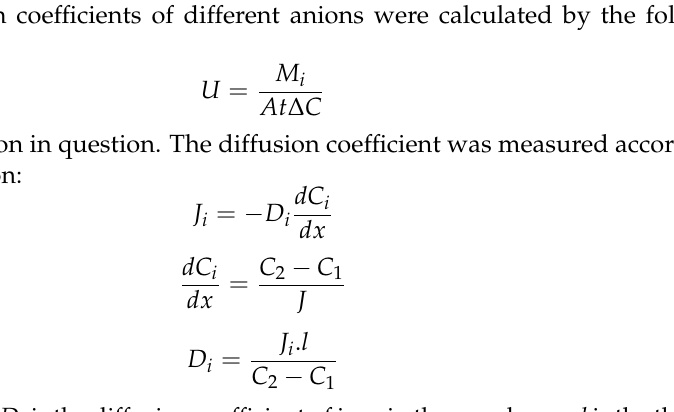
Figure 1. Static diffusion dialysis device to test the permeation coefficients of different anions.